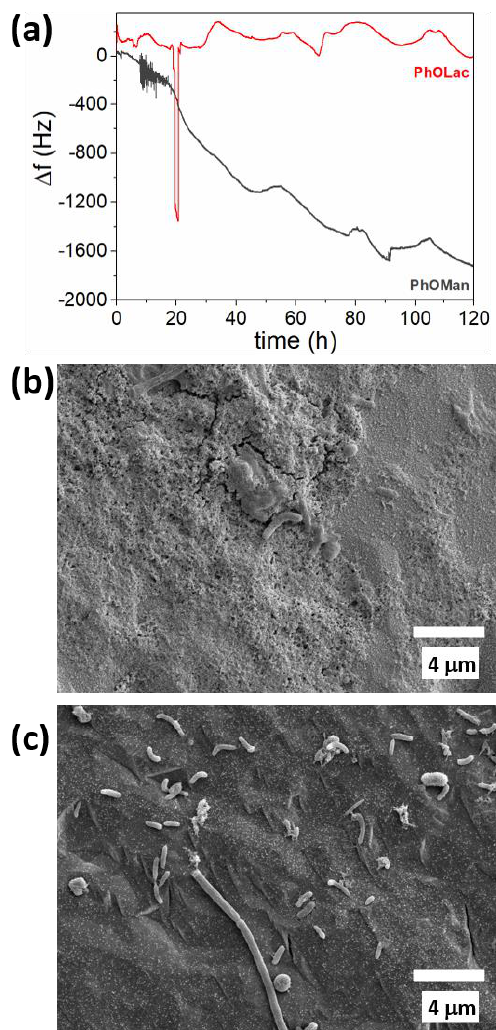
Figure 5. ( a ) Change in resonant frequency of QCM carbon-coated crystals functionalized with PhOLac and PhOMan adlayers as a function of time immersed in a dilute wastewater inoculum; frequency transients observed over the first day (e.g., at 20 h) are attributed to residual sedimentation in the wastewater inoculum. SEM images of the biofilms formed on PhOMan ( b ) and PhOLac ( c ) at the end of the 5 day immersion are also shown.